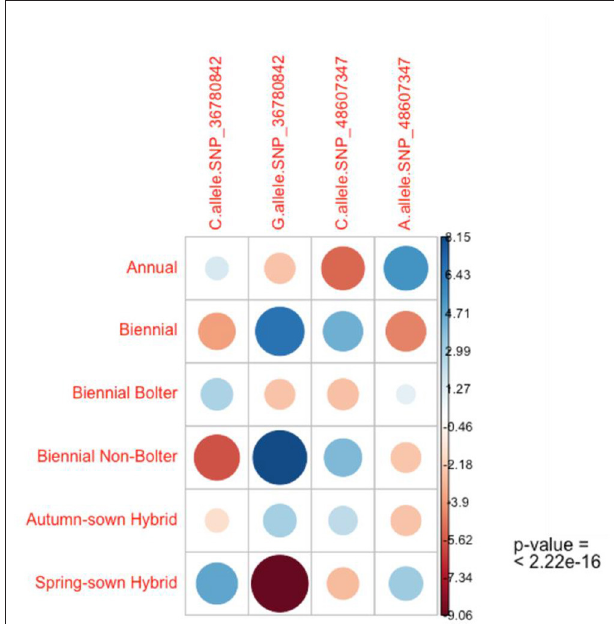
FIGURE 6 | The chi-square test of independence reveals the nature of dependence of the alleles with the phenotypic categories of sugar beets. A strong positive association of the G allele of SNP_36780842 is seen in the biennial, biennial-non-bolter, and autumn-sown categories contrary to the strong negative association seen in the spring-sown varieties and moderate negative association observed in biennial bolters and annual beets. Similarly, a moderate positive association of the C allele of SNP_48607347 is seen in the biennial, biennial-non-bolter, and autumn-sown categories inverse to the negative association seen in the spring-sown variety, biennial bolter and annual individuals. The p -value of the standardized residuals is significant ( p <